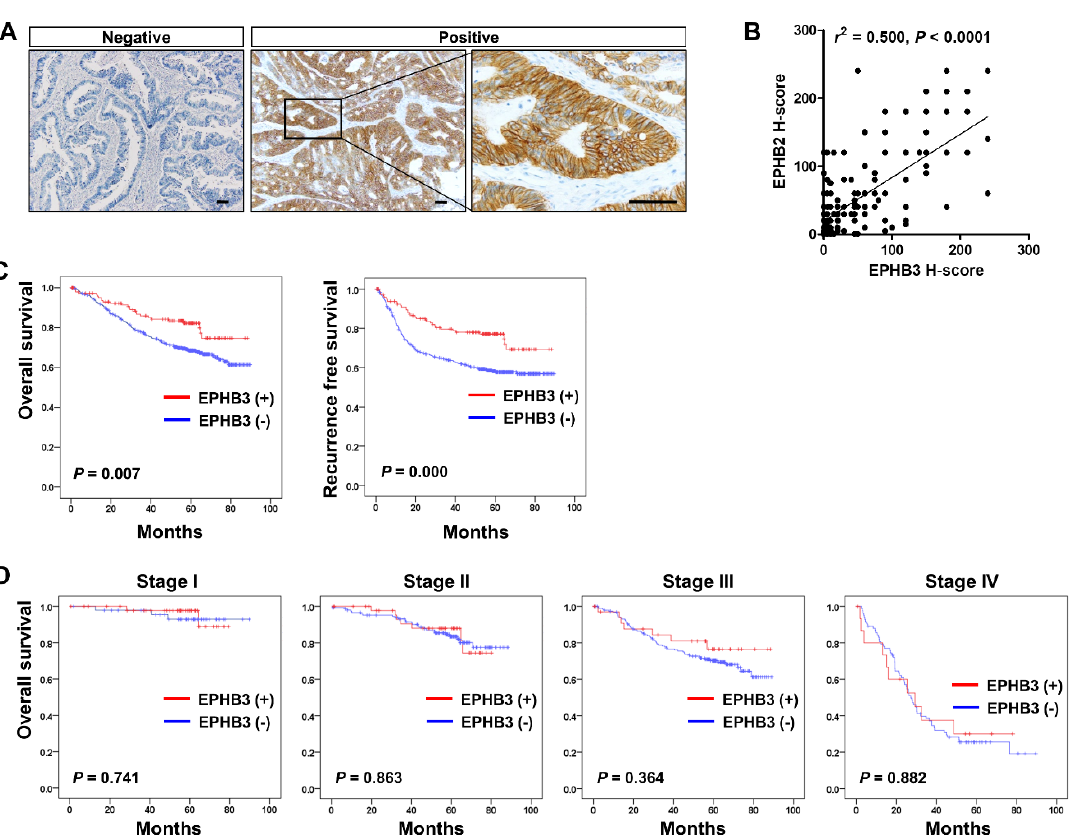
by black arrow heads, mice (DSS: n = 4, AOM/DSS: n = 5) were sacrificed for analysis. Representative photos of colons harvested on day 0 and day 71 show visible tumors indicated by white arrows. ( B ) Real-time PCR analysis revealed increased EPHB3 expression on days 65 and 71. ( C , D ) RNA in situ hybridization for EPHB3 expression during colitis-associated colon cancer development. Data represent the means ± SEM. SEM: standard error of the mean. * p < 0.05, ** p < 0.01.